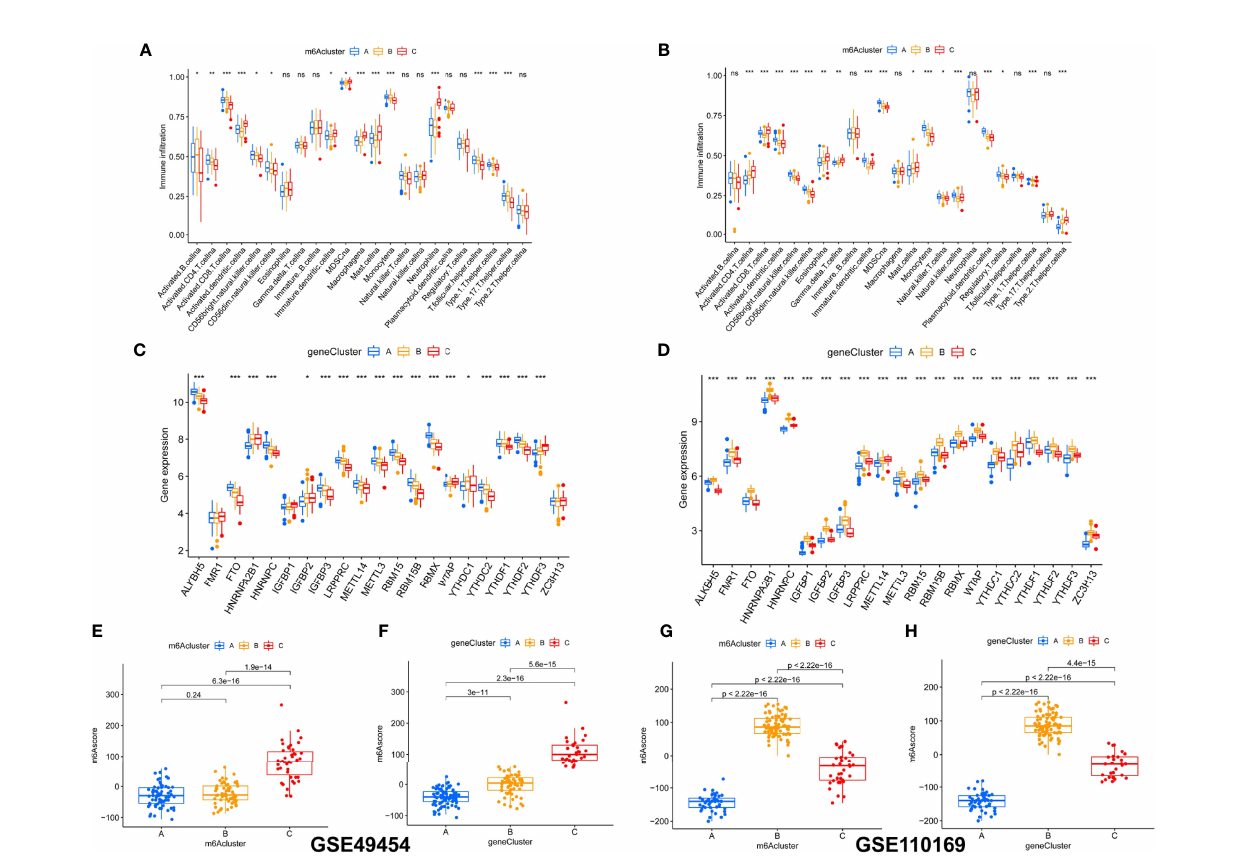
FIGURE 6 | Comparison of the differences in immune cells, m6A regulators, and the m6A score in unsupervised clustering of cohorts. (A – D) Comparison of the difference of 23 types of immune cells and 21 m6A regulators on the m6A and gene clusters in the GSE49454 and GSE110169 cohorts. (E – H) Comparison of the differences in m6A score on molecular subtypes (gene clusters and m6A clusters) in GSE49454 and GSE110169 datasets. p-values are shown as *p < 0.05; **p < 0.01; ***p < 0.001. ns, not signi fi